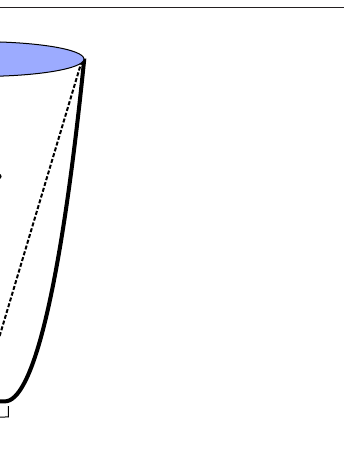
Figure 1: The corresponding singularity is pointlike and may be then resolved by gluing in a copy of X